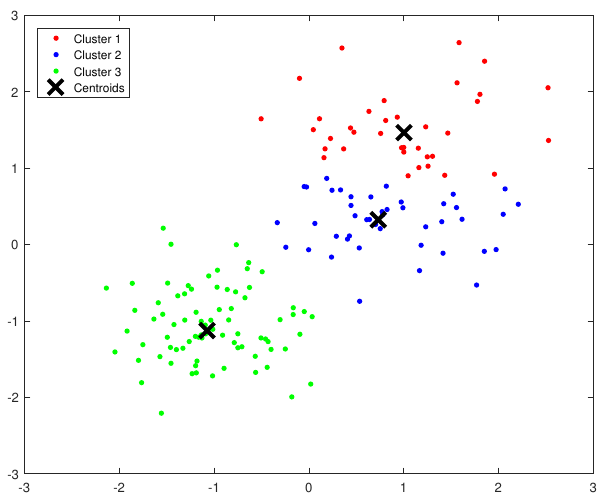
Figure 12. A total of 80 sensor nodes clustered into 3 clusters according to the K means algorithm, the centroids represent the locations of the UGVs with holding the wireless charging stations.